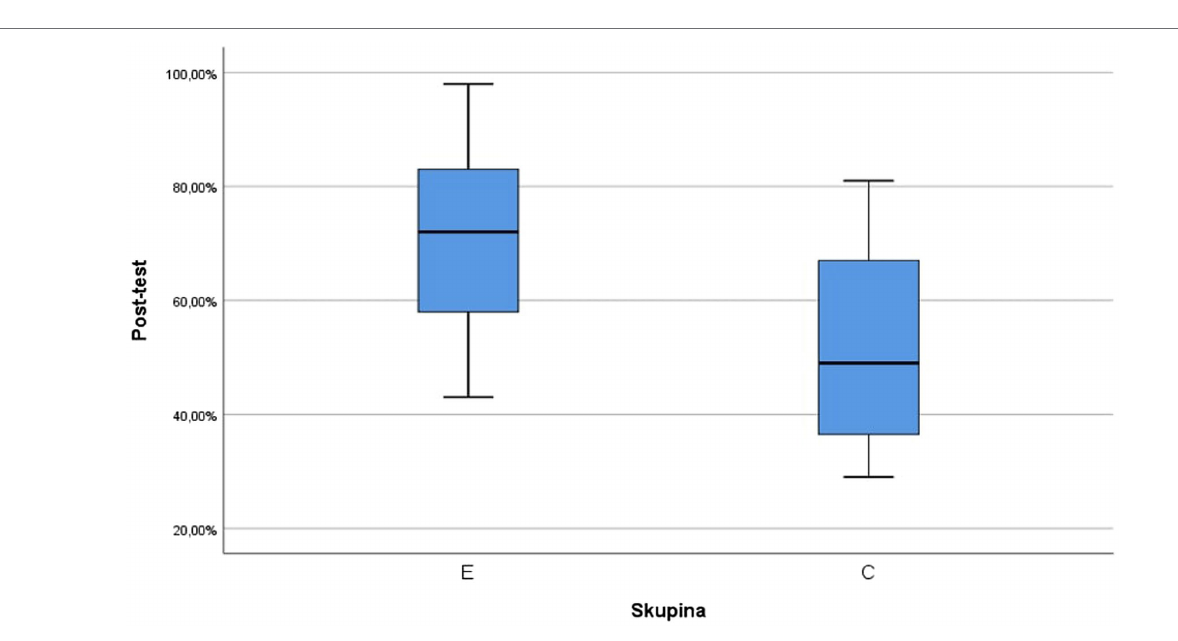
FIGURE 5 | Box diagram of post-test results for the experimental (E) and control (C) groups,